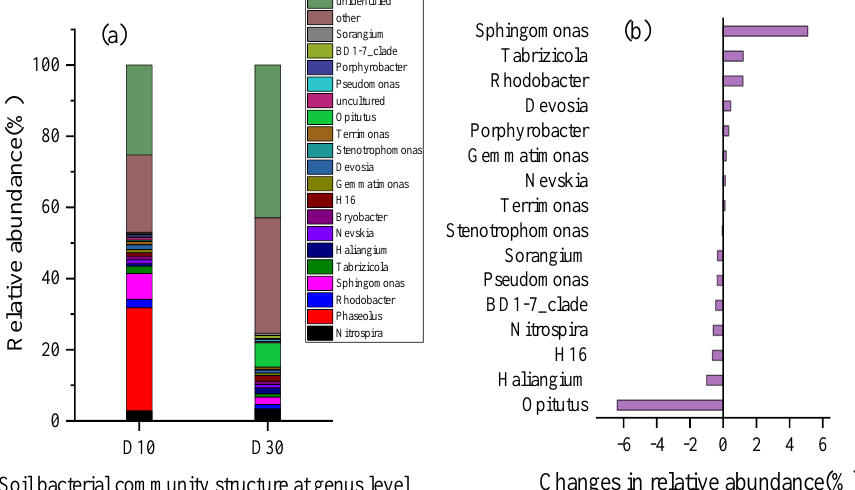
Figure 6. Soil microorganism changes in the wetland sediments at the genus level. ( a ) Soil bacterial community structure at genus level; ( b ) changes in relative abundance.